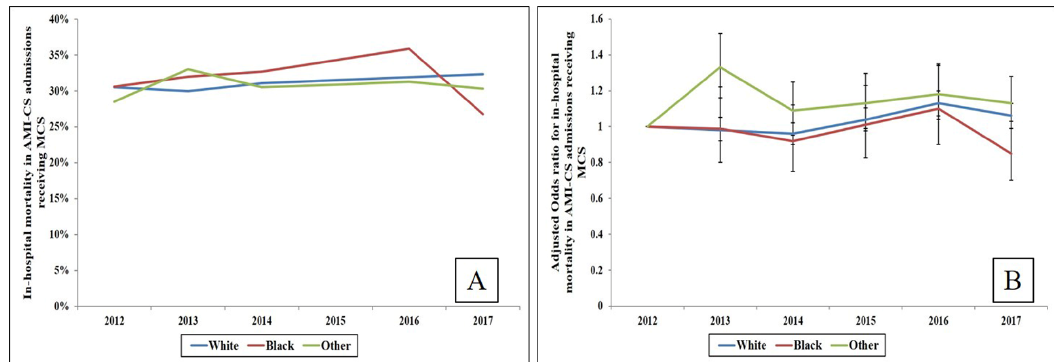
Figure 3. Trends of in ‐ hospital mortality in race sub ‐ groups of AMI ‐ CS admissions receiving MCS. ( A ) Unadjusted in ‐ hospital mortality in race sub ‐ groups of AMI ‐ CS admissions supported with MCS ( p < 0.001 for temporal trend only for